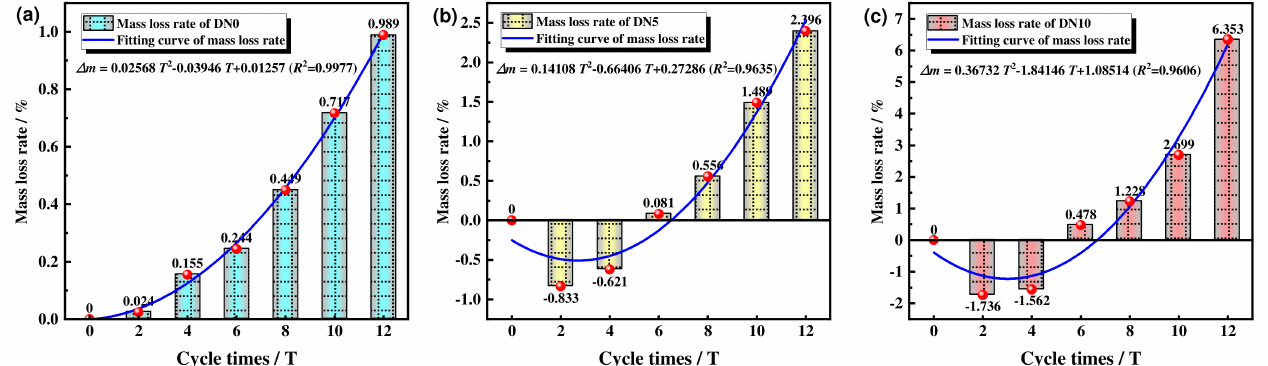
Figure 7. Mass losses rate of SWCPB for different cycles. ( a ) Mass loss rate and fitted curves for DN0; ( b ) Mass loss rate and fitted curves for DN5; ( c ) Mass loss rate and fitted curves for